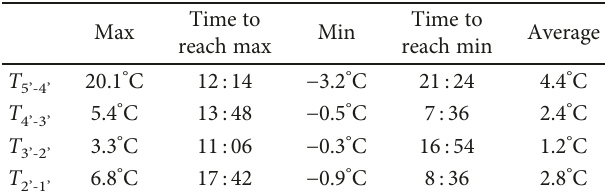
Table 6: Summarized result of temperature di ff erence between nodes of the interior air